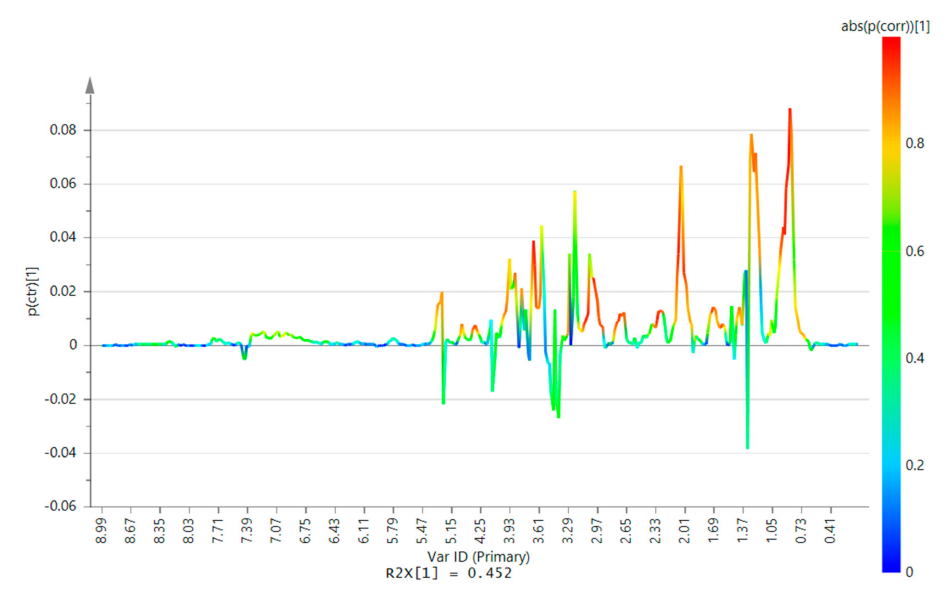
Figure 3. Orthogonal projection to latent structures-discriminant analysis (OPLS-DA) S-line plot of the AT samples versus the sham and BT samples. An increasingly red color of the spectral line indicates higher importance to the di ff erentiation of the AT samples from the rest. Positive y-axis values indicate decreased levels after injury of associated features after trauma, while negative values indicate increased levels after injury. Features di ff erentiating AT samples: (1) cholesterol, (2) LDLs and VLDLs, (3) acetylglycoproteins (N-AG), (4) albumin (lysyl), (5) lipids, (6) SN-glycerophosphocholine (SN-GPC), (7) unsaturated lipids, (8) lactate, (9)